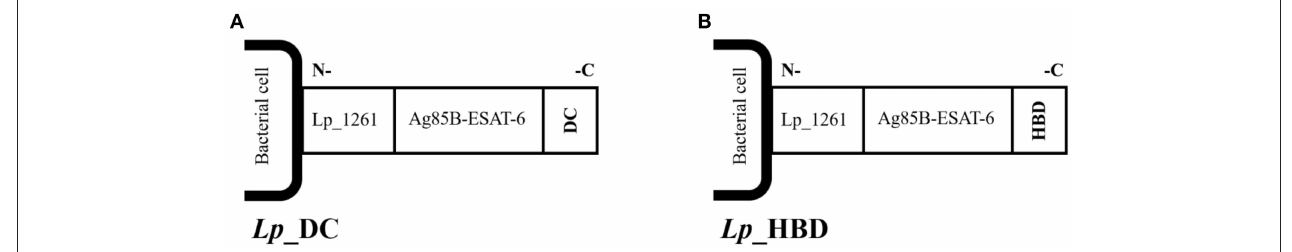
FIGURE 1 | Schematic overview of the surface-anchored recombinant AgE6 fusion antigen. The N-terminal end of the recombinant AgE6 hybrid antigen was fused to the Lp_1261 lipoprotein anchor which attaches the protein to the cell membrane. Specific targeting peptides, here referred to as DC (A) or HBD (B) , were fused to the C-terminal end (i.e., the ESAT-6 side) of the AgE6 fusion antigen and thus form the most exposed part of the surface-anchored antigen. The DC-peptide targets dendritic cells, whereas the HBD fragment targets bacteria to epithelial